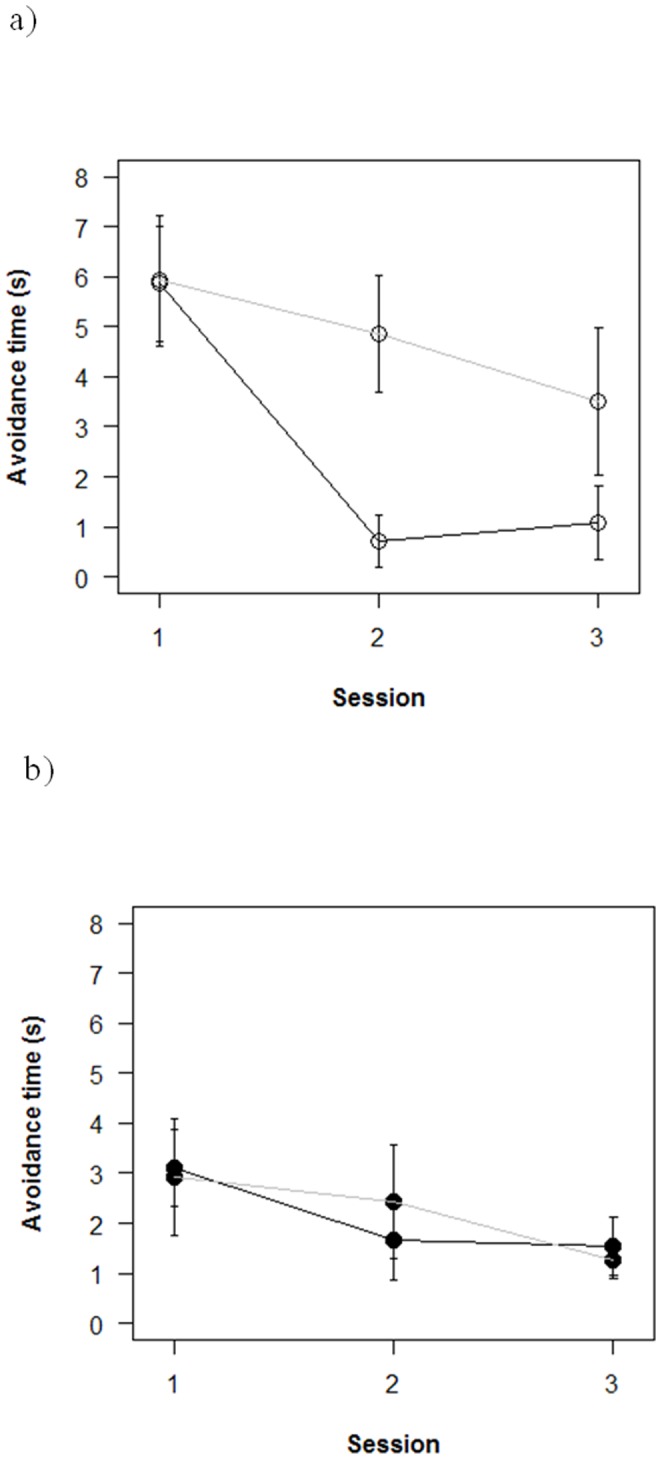
Sex effect of experienced fish (key and non-key) differs according to genetic background.4a) Groups with experienced females avoided the aversive stimulus slowly at the first session, but improved performance more quickly when the experienced female was a Key fish (black line) as opposed to a non-Key fish (gray line). 4b) Groups with experienced males avoided quickly from the first trial, and showed little change in performance across the three sessions leading to a significant interaction effect. Error bars are one standard error. Data are for the same trials as in Fig. 3, but combining data from PN and SH strains.